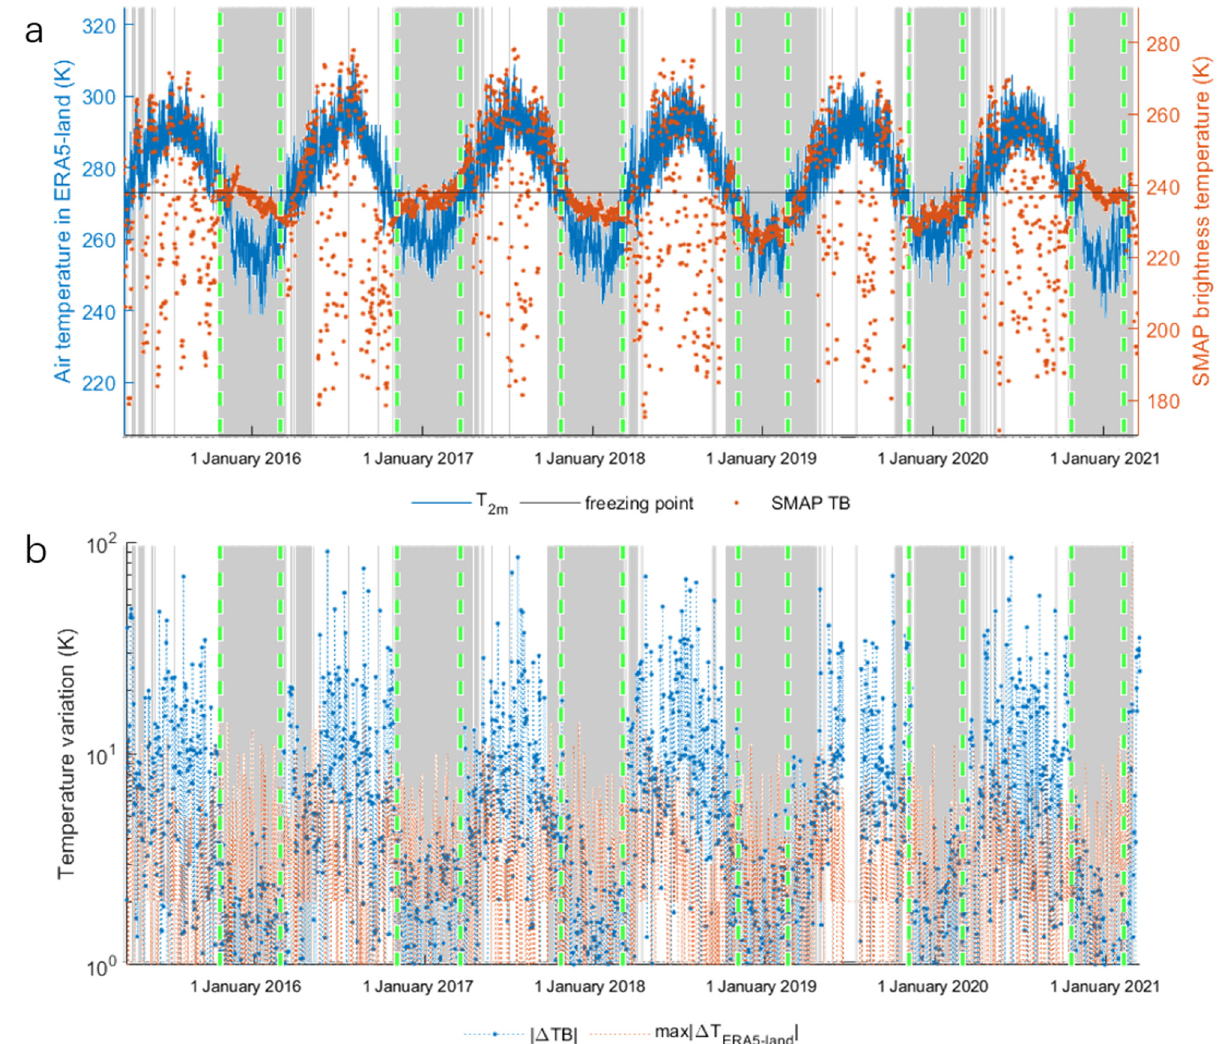
Figure 3. ( a ) Time-series of 2-meter air temperature T 2 m , and SMAP TB at the Xilinhot site; ( b ) time series of | ∆ TB | computed from the SMAP TB s and max | ( ∆ T ERA 5 − land ) | . The vertical green dashed lines indicate the beginning and ending day of the soil frozen state as inferred from the new FT algorithm. The gray shades the frozen state inferred from SMAP FT product.